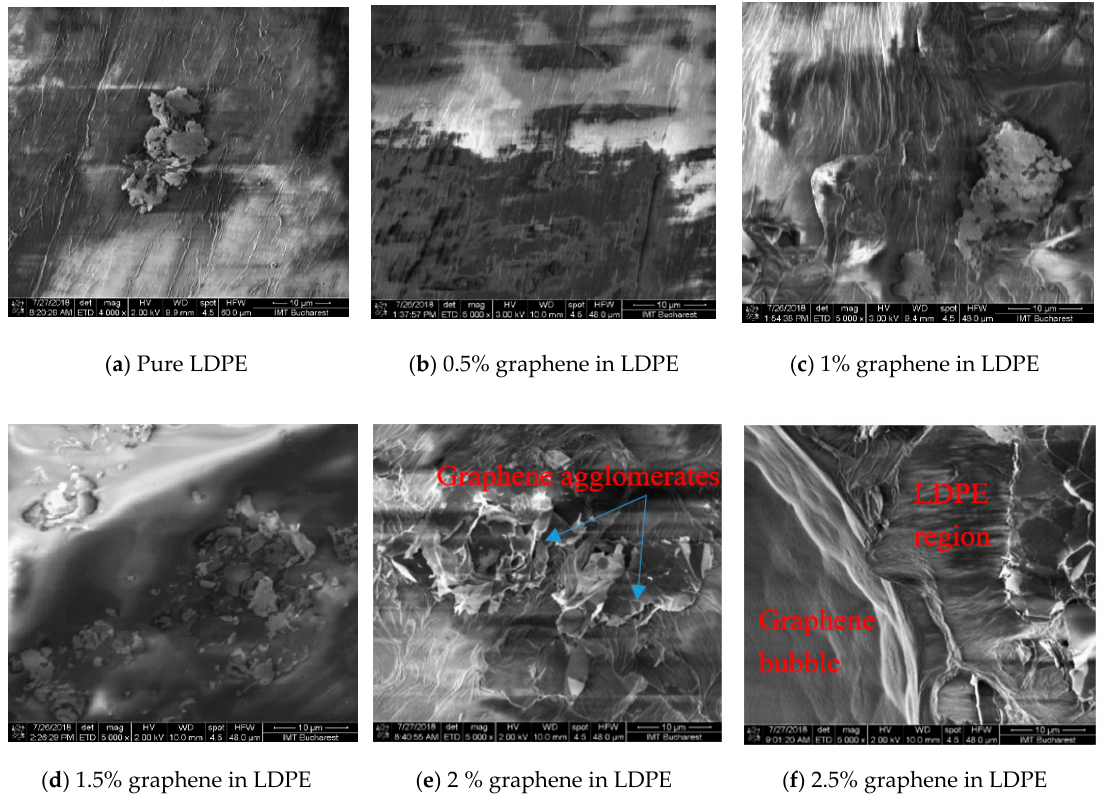
Figure 1. SEM images of samples fabricated at lower concentrations, showing the evolution of materials morphology (×5000 magnification, scale 10 μ m).